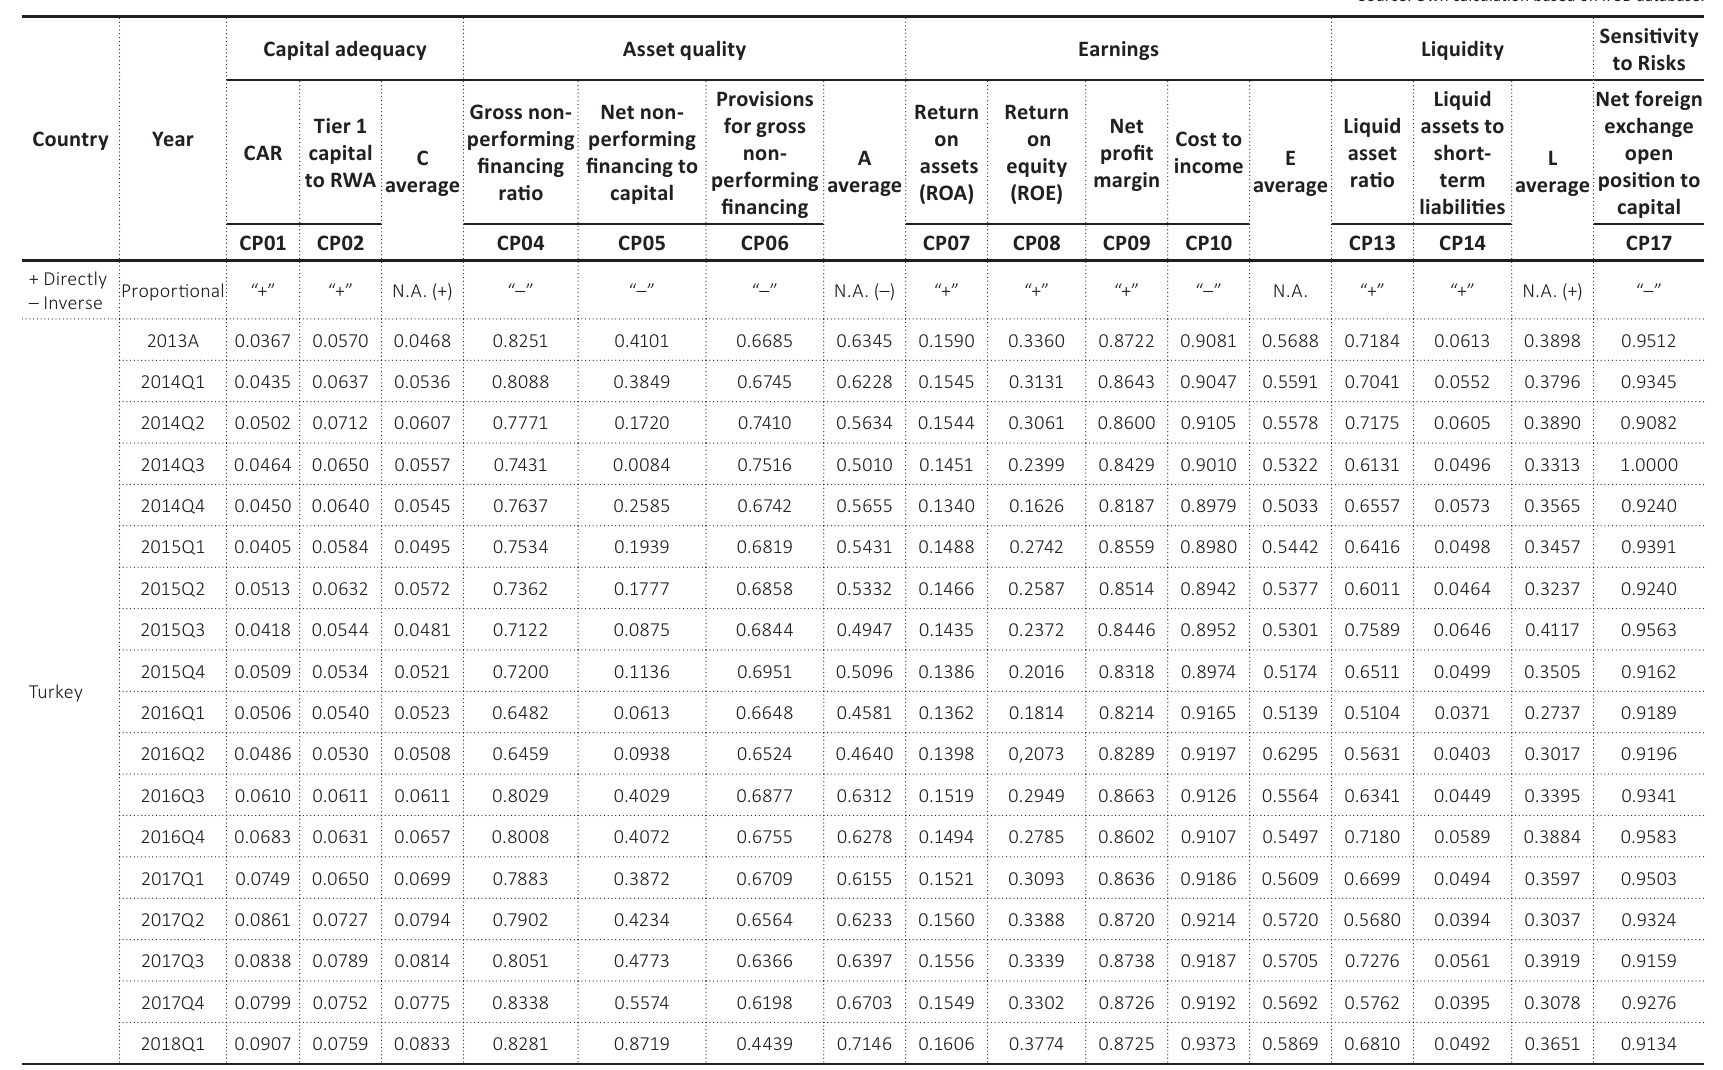
Table A5. Standard CAELS data of Turkey